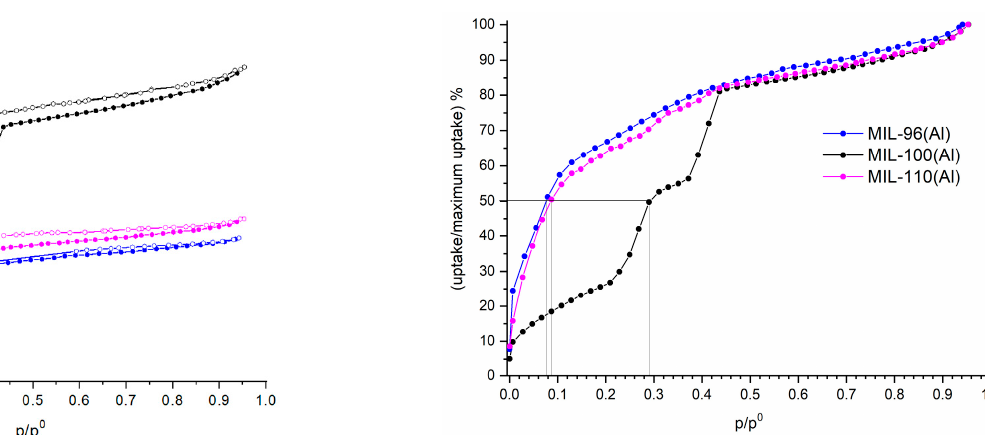
Figure 3. Water sorption isotherms of MIL-96(Al) (blue), MIL-100(Al) (black) and MIL-110(Al) (ma- genta) at 313 K ( left ) and ratio of water uptake to its maximum value in function of relative pressure